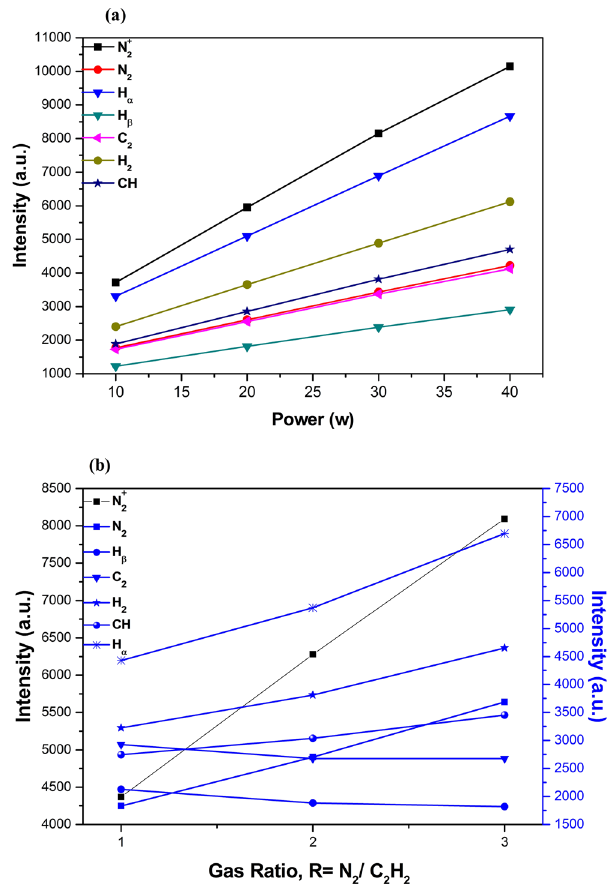
Figure 3. Emission intensities of the main active species as a function of ( a ) applied power in R = 1 and ( b ) gas ratio in P = 20 (w).